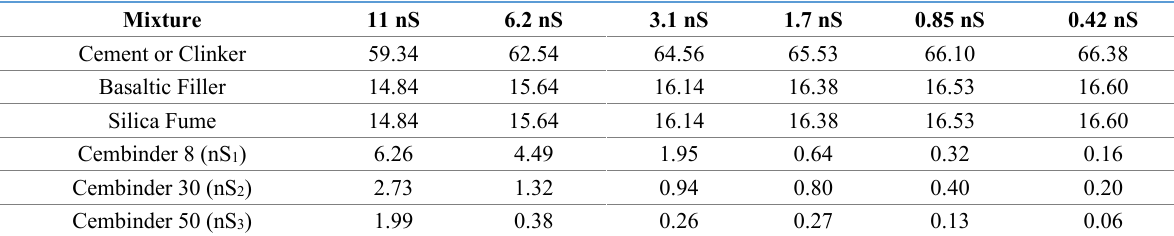
Table 2. Composition of mixtures